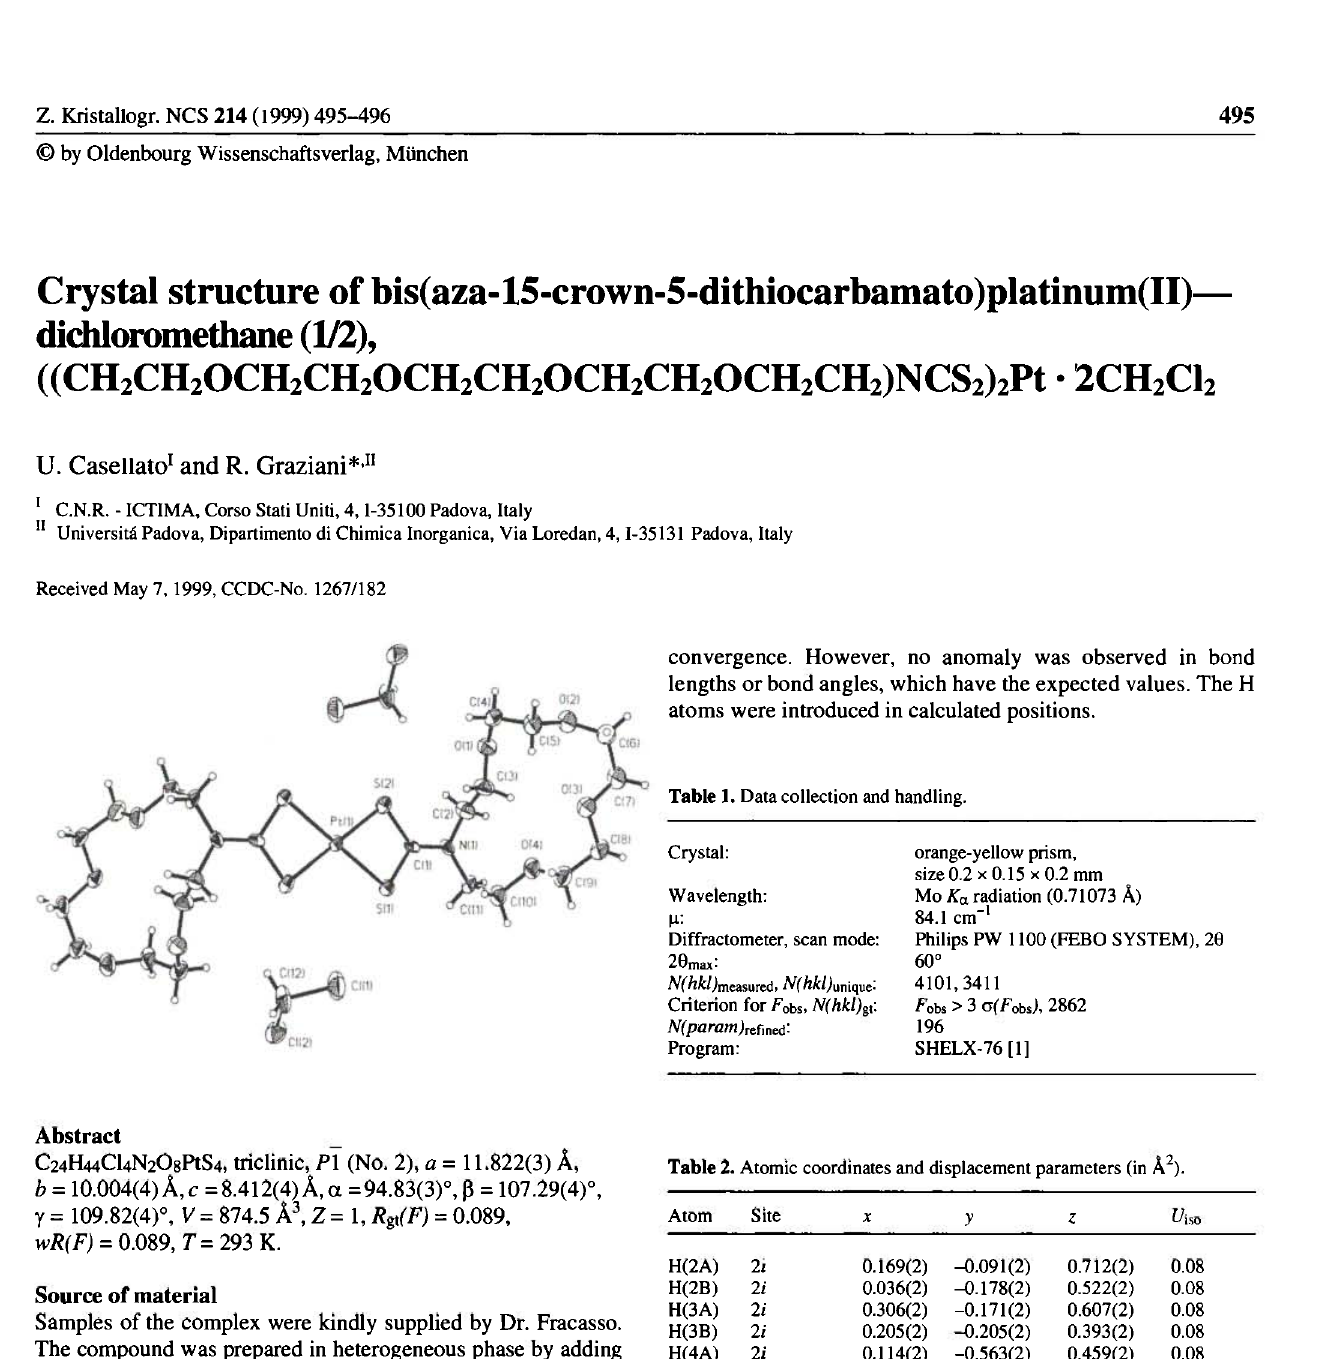
Table 2. Atomic coordinates and displacement parameters (in Ä 2